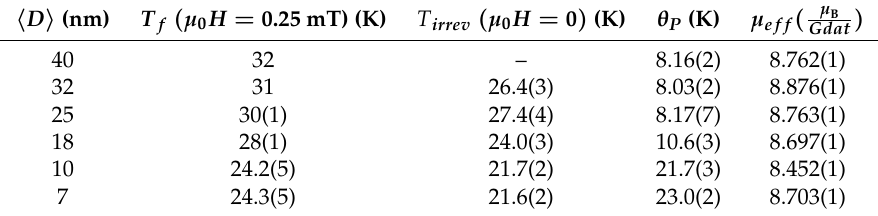
Table 2. Irreversibility temperature associated with the freezing (SG) transition measured at 0.25 mT, T f ( H = 0.25 mT), T irrev obtained from AT line extrapolation described in Equation (1), paramagnetic Curie temperature θ P and effective magnetic moment µ ef f obtained from Curie-Weiss fitting of FC measurements taken at µ 0 H = 0.1 T for the different GdCu 2